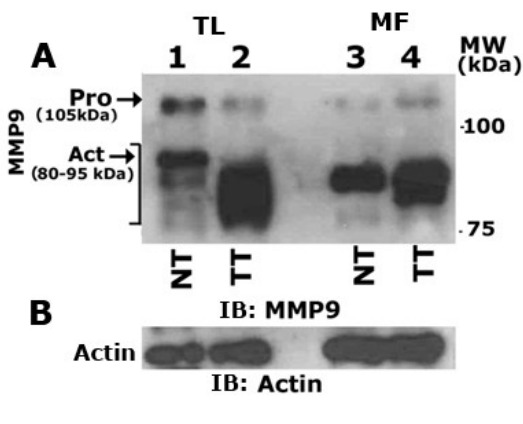
Figure S2. Expression levels of MMP9 in human prostate normal (NT) and tumor